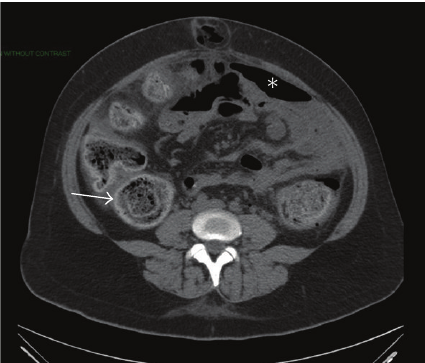
Figure 3: Resected specimen with multiple large fecaliths of varying size and serosal hemorrhage (arrow) on bowel